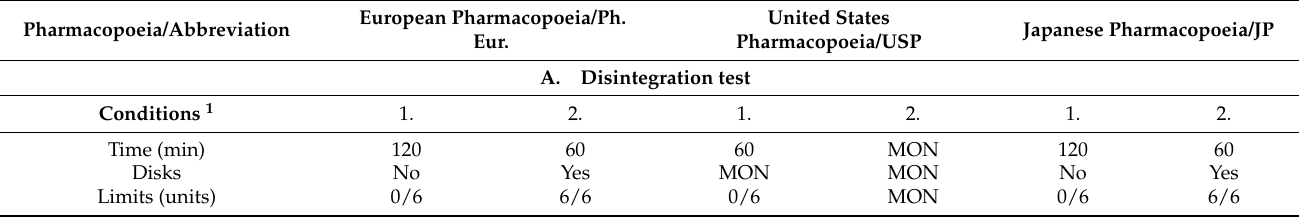
Conditions and limits in three different pharmacopeias (European, Unites States, Japanese)